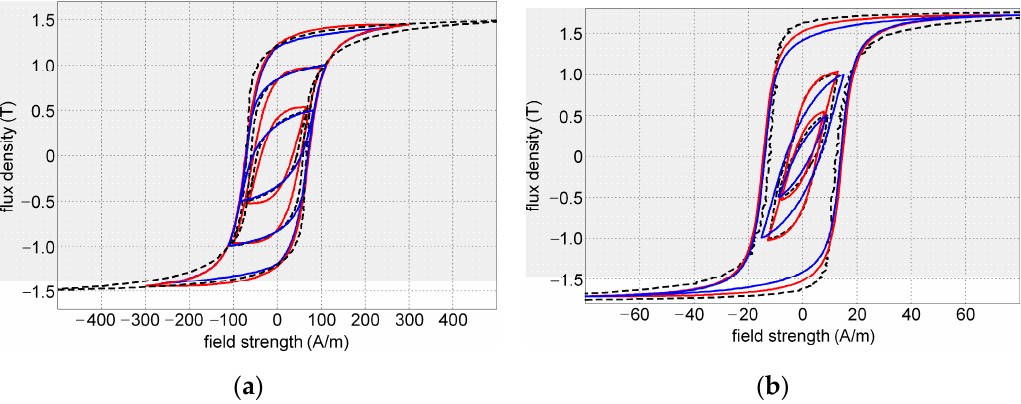
Figure 10. Symmetrical hysteresis loops for some assumed values of the field strength: ( a ) the dynamo sheet M530-50A; ( b ) the transformer sheet M120-27S for the rolling direction; black line—measured loops, red and blue lines—calculated loops using the basic or inverse approximation of the hysteresis loop.